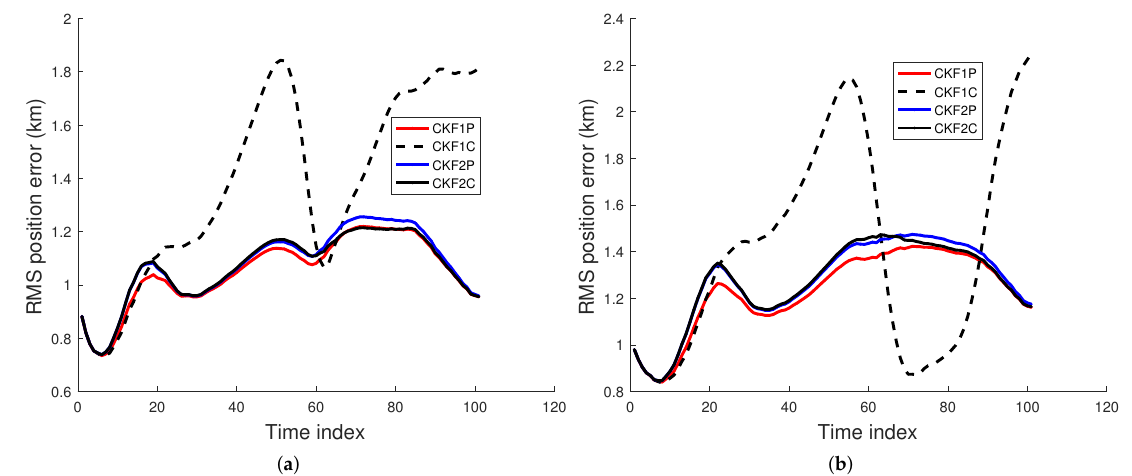
Figure 5. RMS position error using the prior variance P 0,p,1 from 500 Monte Carlo runs. ( a ) Angle SD of 1 mrad, ( b ) Angle SD of 2 mrad.